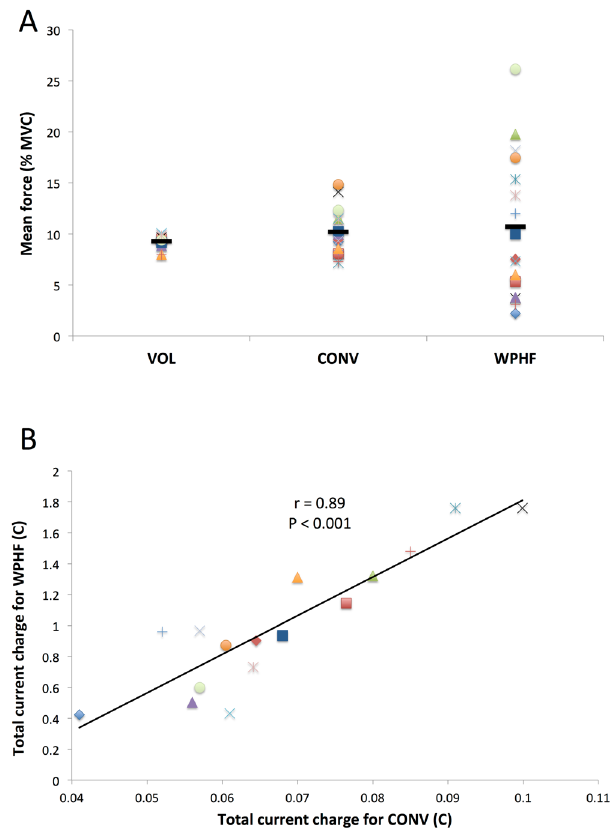
Figure 1. ( A ) Mean force recorded during VOL, CONV and WPHF protocols. The horizontal black bar represents the mean value for a given protocol whereas the symbols display individual values. Note the large inter- individual variability of mean force during WPHF. ( B ) Correlation between total current charge applied during WPHF and CONV protocols. Symbol colour and shape correspond to the same subject displays in panel A.